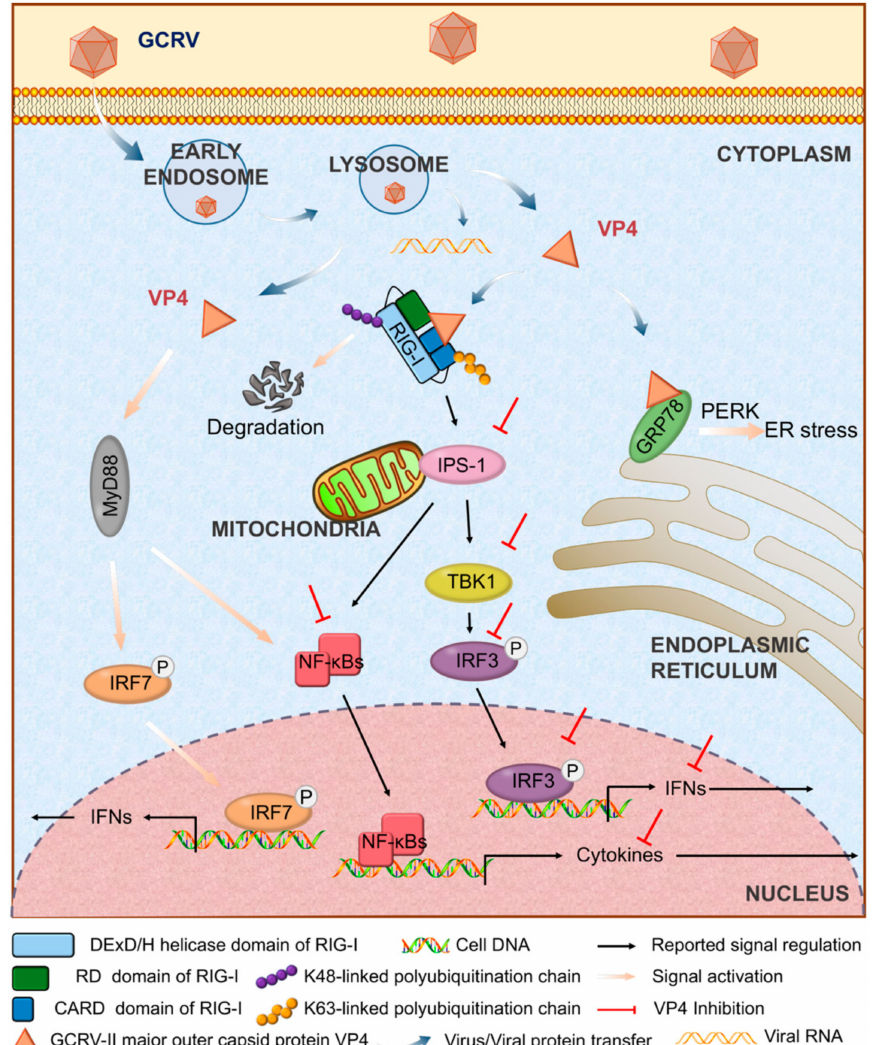
Figure 8. Regulatory model of VP4 in antiviral signaling in grass carp. Upon GCRV infection, GCRV-II major outer capsid VP4 enters into cytoplasm via early endosome and lysosome. VP4 targets RIG-I and GRP78 and results in different responses to suppress antiviral immunity and facilitate GCRV replication. VP4 interacts with CARD domain and RD domain of RIG-I in cytoplasm. After association with VP4, K48-linked ubiquitination of RIG-I is enhanced leading to RIG-I degradation. Consequently, signal transductions from RIG-I to downstream adaptors IPS-1 and STING are inhibited. Furthermore, VP4 restrains expression and phosphorylation of IRF3 and the subsequent signals of IFNs and NF- κ B. VP4 binds GRP78 to activate ER stress via PERK-eIF2 α mediated unfolded protein response. Meanwhile, dissociative VP4 protein also triggers MyD88-dependent TLR signaling pathway and induces production and phosphorylation of IRF7 and subsequent IFN